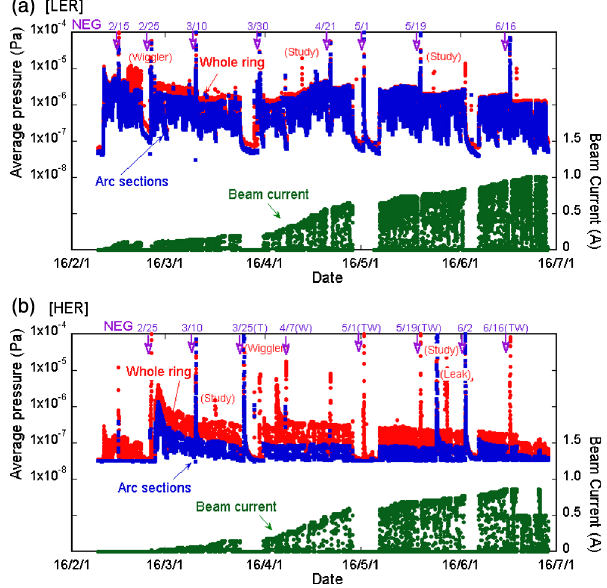
FIG. 3. Histories of the average pressure in the whole ring (red circles), average pressure in the arc sections (blue squares), and stored beam currents for (a) the LER and (b) the HER. Arrows indicate the NEG conditioning times; here, “ T ” and “ W ” mean that the NEG was conditioned only at the “ Tsukuba straight section ” and “ Wiggler sections, ” respectively.